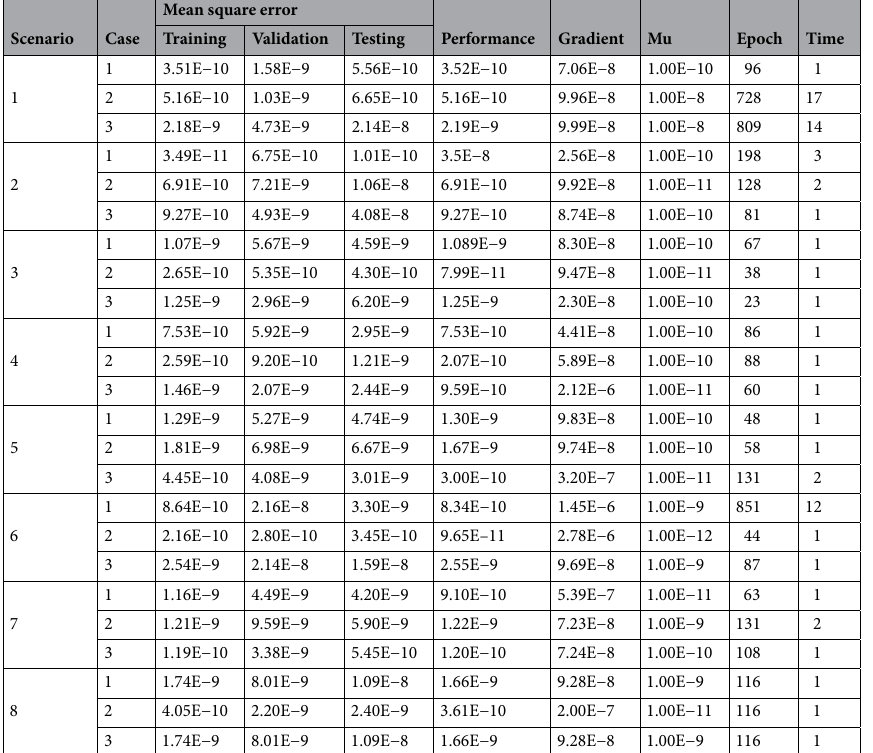
Table 4. Various statistics of scenarios (1–8) for cases (1–3) of TFFMFTDECR model.